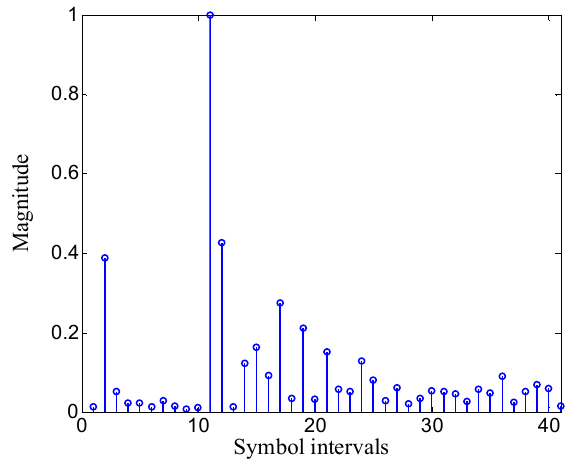
Table 1. Parameters for simulation analysis. Parameters